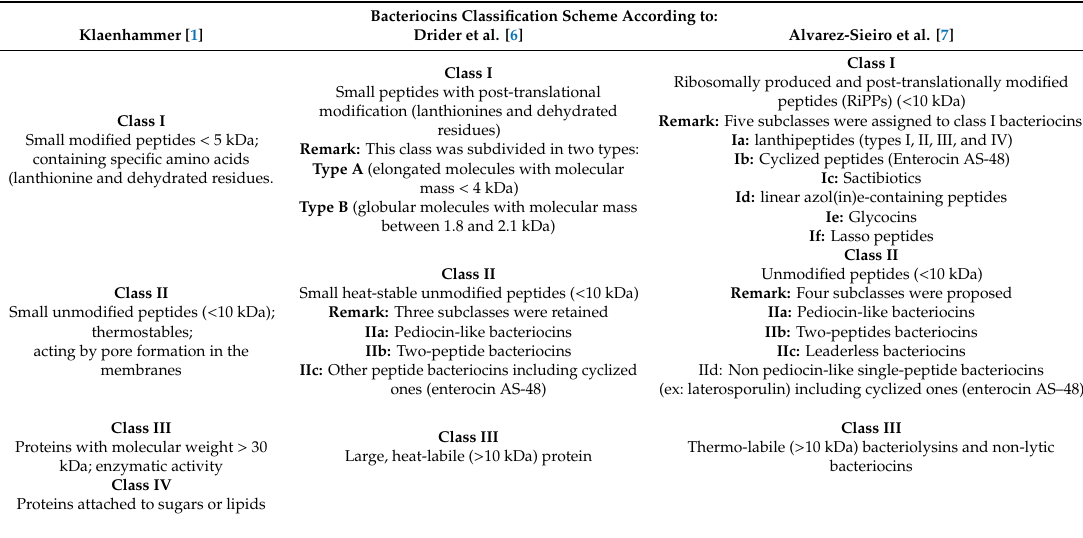
Table 1. The main classification schemes of